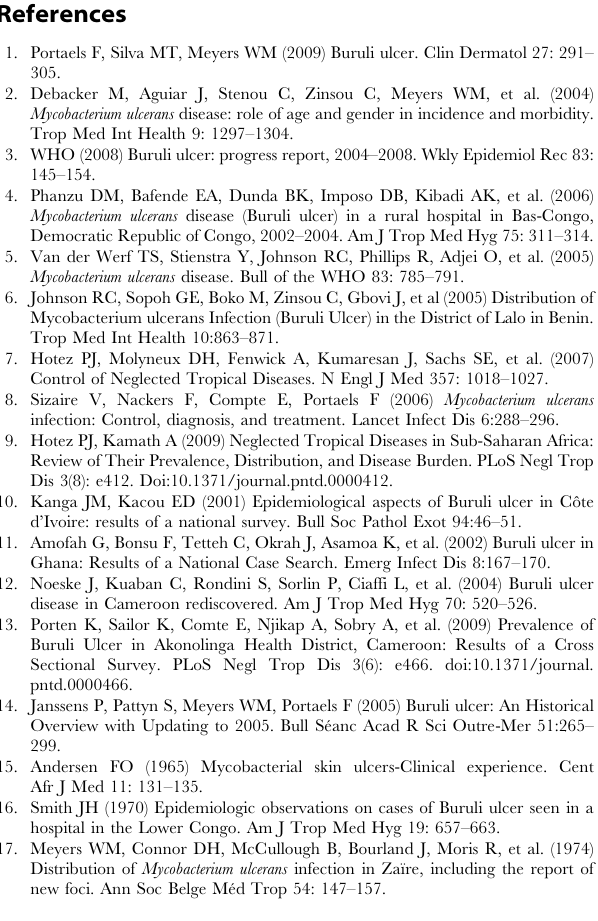
Figure S1 Distribution of confirmed active BU cases in the Songololo Territory, July–August 2008. Figure S2 Distribution of inactive BU cases in the Songololo Territory, July–August 2008. Table S1 Distribution of active and inactive BU cases in the Rural Health Zone of Kimpese (July–August 2008).